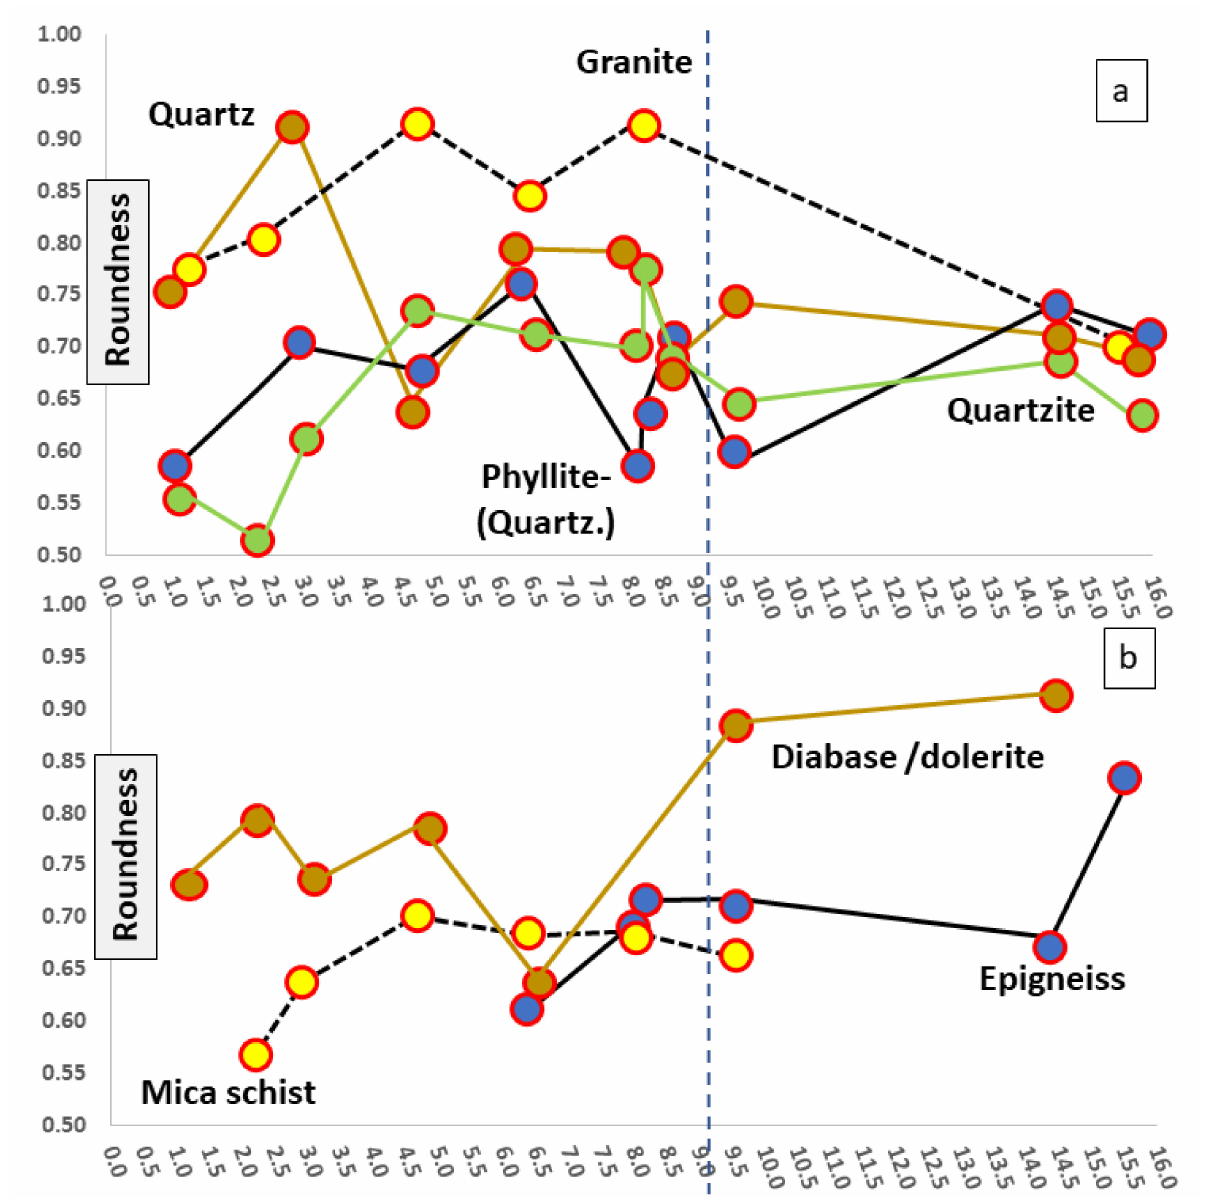
Figure 12. Variation of grain shape as a function of lithology along the talweg. ( a ) Variation of roundness of granite, quartz, phyllite-(quartzite) and quartzite gravel along the talweg. ( b ) Variation of roundness of mica schist, diabase/dolerite, and epigneiss gravel along the talweg. See also Figure 5 for